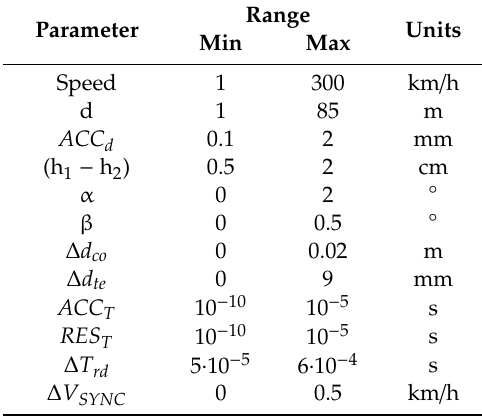
Table 2. Variability ranges of the sources of